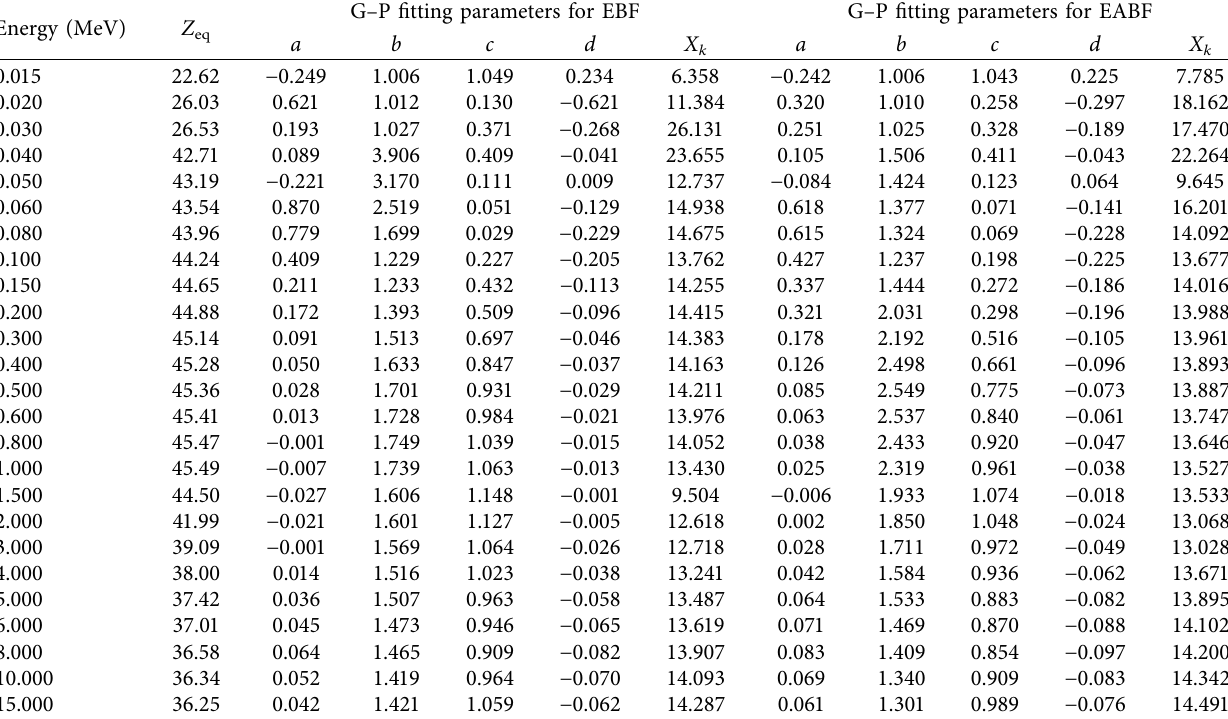
k , and d ) of the S1